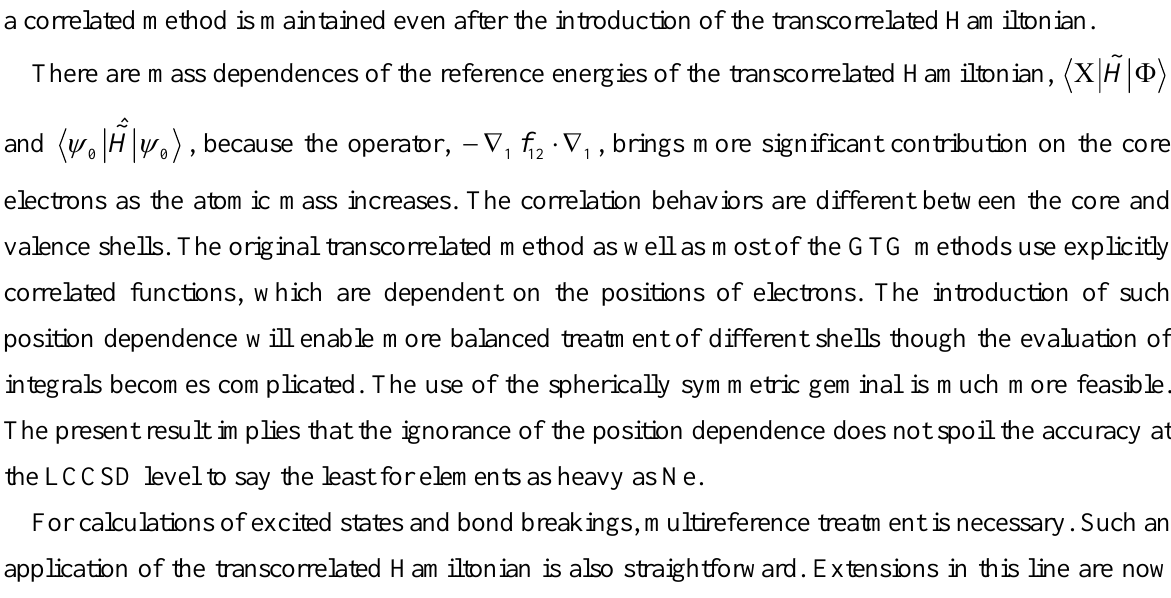
Table III. Correlation energies of Ne, HF, H